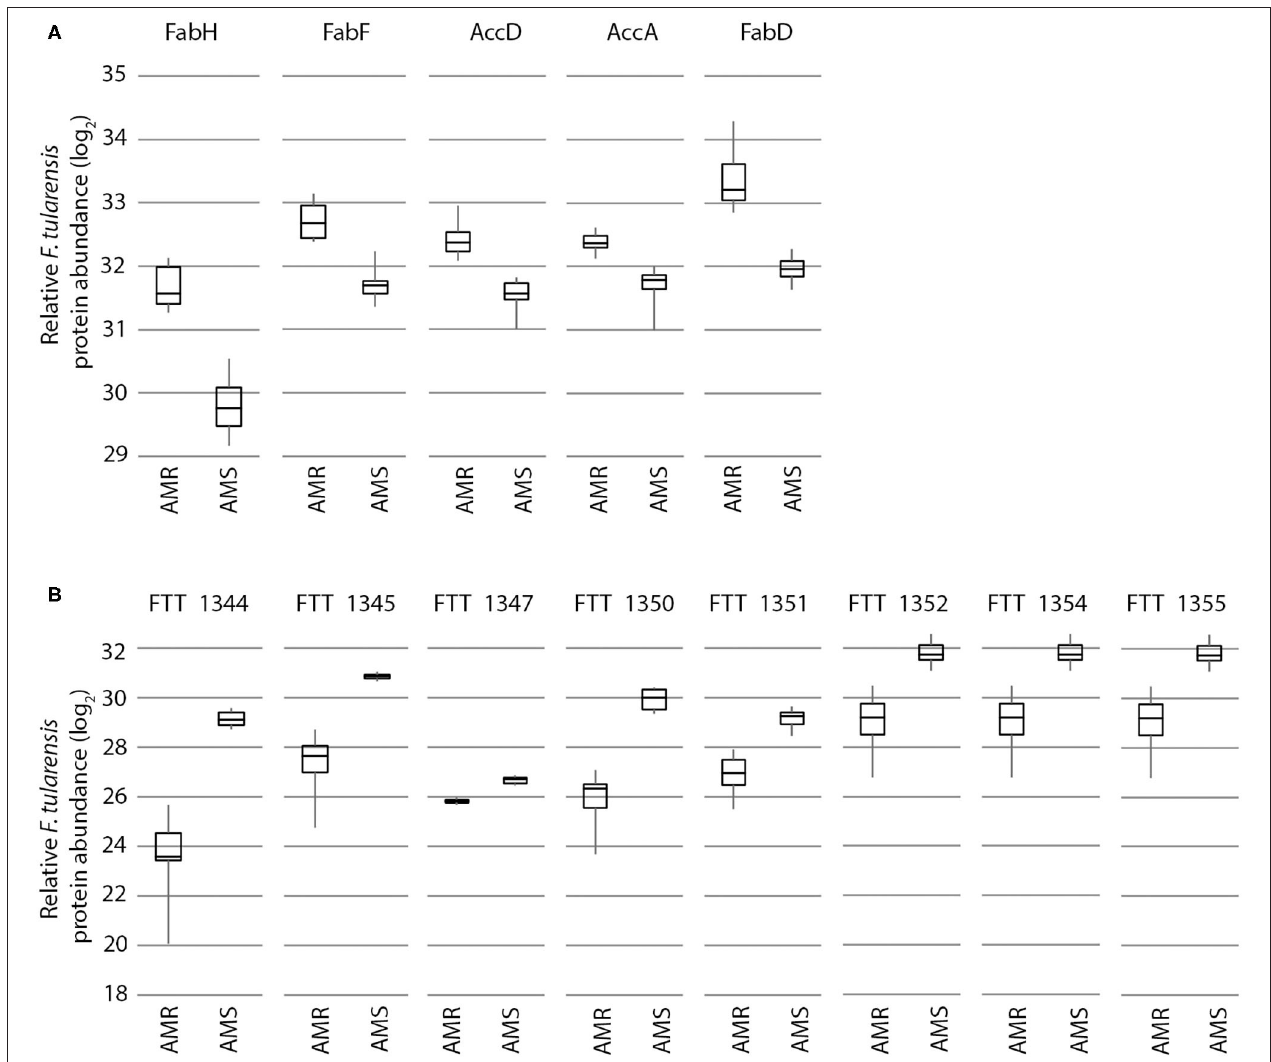
FIGURE 3 | Expression of proteins from specific cellular pathways and functions in F. tularensis are influenced by AMR status in a significant, bidirectional manner. Proteins from the fatty acid biosynthesis pathway (A) and Type 6 secretion system (B) are increased and decreased in the AMR strain vs. the AMS strain, respectively. Shown here is an example with the FSC232 (AMR) and FSC201 (AMS) strain pair (data from the early time point in the absence of antibiotic), but these same trends are also observed in the FSC016/FSC013 strain